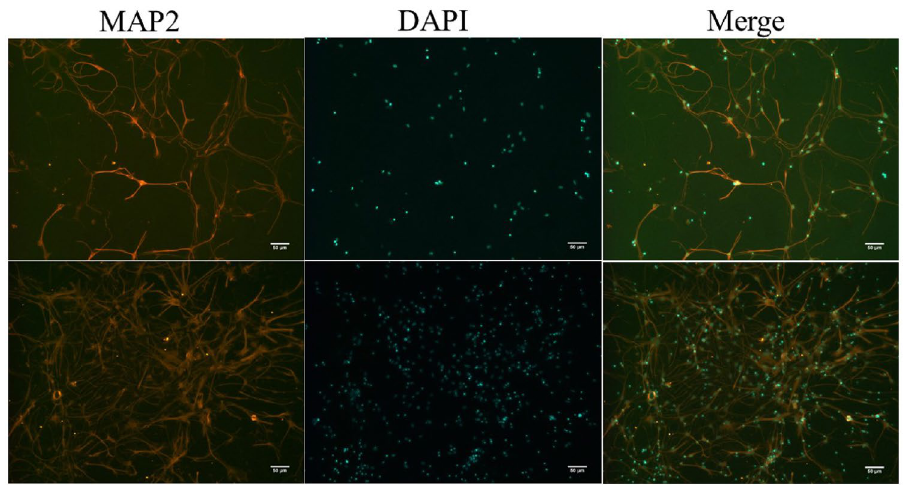
Figure 1. Immunofluorescence staining of rat hippocampal neurons (×200). The cell bodies and processes of hippocampal neurons stained with MAP2 antibody were orange-red, all nuclei stained with DAPI were blue, Merge was a dual fluorescence image after the integration of orange-red MAP2 and blue DAPI images (×200).